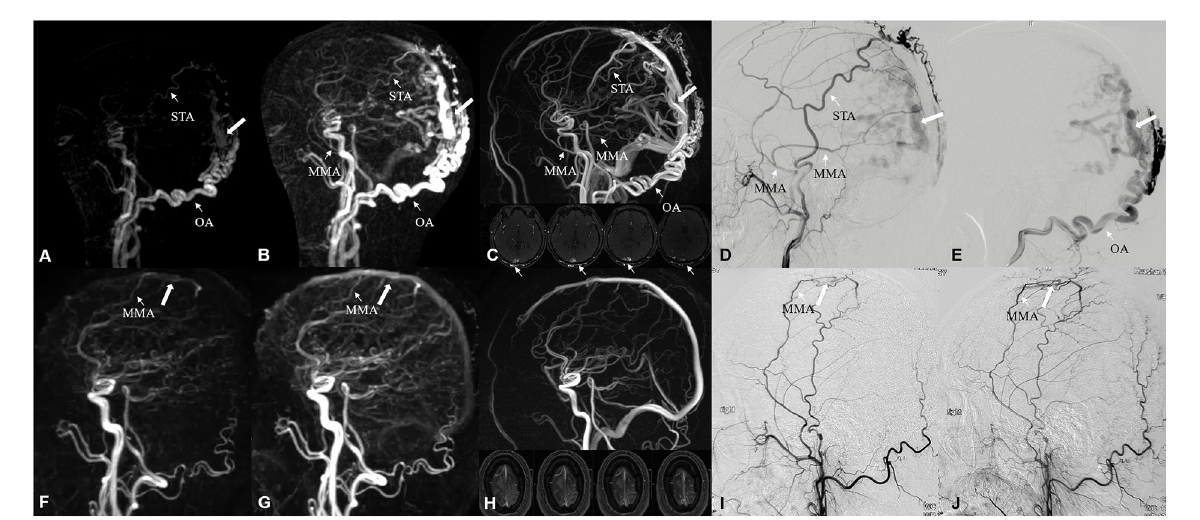
FIGURE4 A 48-year-old male suffered from neck and occipital pain for more than 2 years, and aggravated in the past month. Occipital artery (narrow arrow) feeding DAVF, located on the bridge vein (white arrow) of occipital superior sagittal sinus, was identified by DISCO-MRA (A,B) and TOF-MRA (C) , which was confirmed by DSA (D,E) . The feeding arteries were parietal branch of the left STA, posterior convexity branch of the left MMA and transosseous branch of OA. A 45-year-old male suffered from repeated right limb epilepsy accompanied with aphasia for 40 days. Middle meningeal artery (narrow arrow) feeding low-flow DAVF, located on the parietal bridge vein (white arrow), was detected by DISCO-MRA (F,G) with TOF-MRA missed diagnosis (H) , which was ascertained by DSA (I,J) . The feeding artery was parietal branch of MMA. STA, superior temporal artery; MMA, middle meningeal artery; OA, occipital artery.